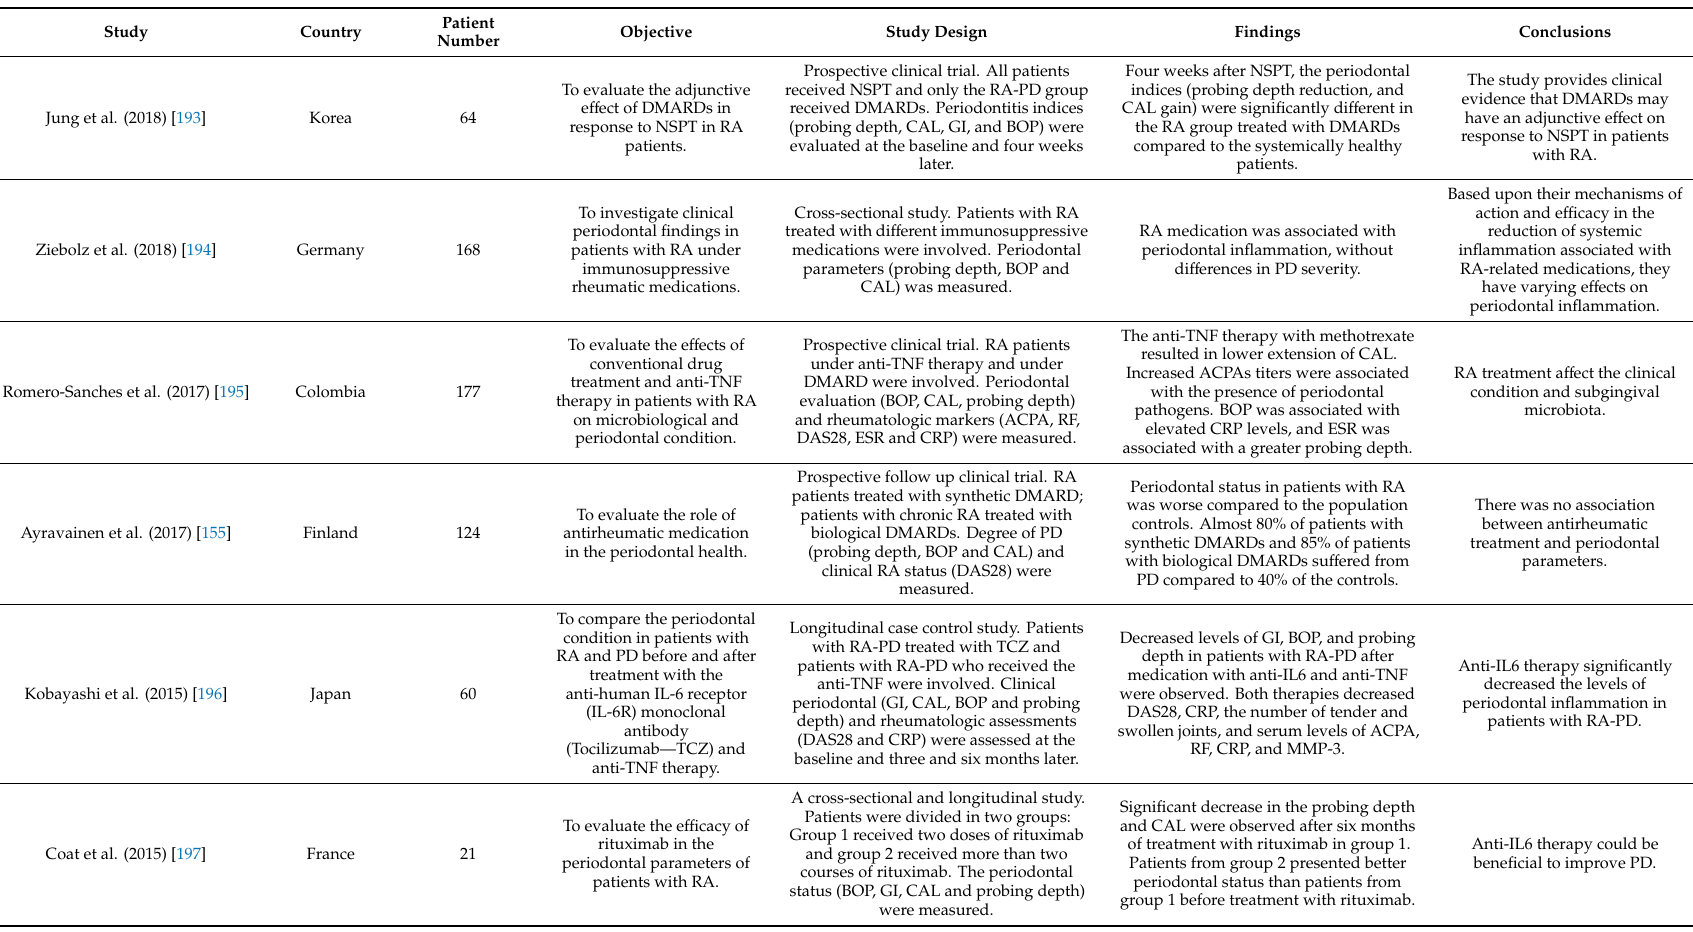
Table 1. Evidence table summarizing the main outcomes of clinical trials evaluating the RA treatment in patients with established